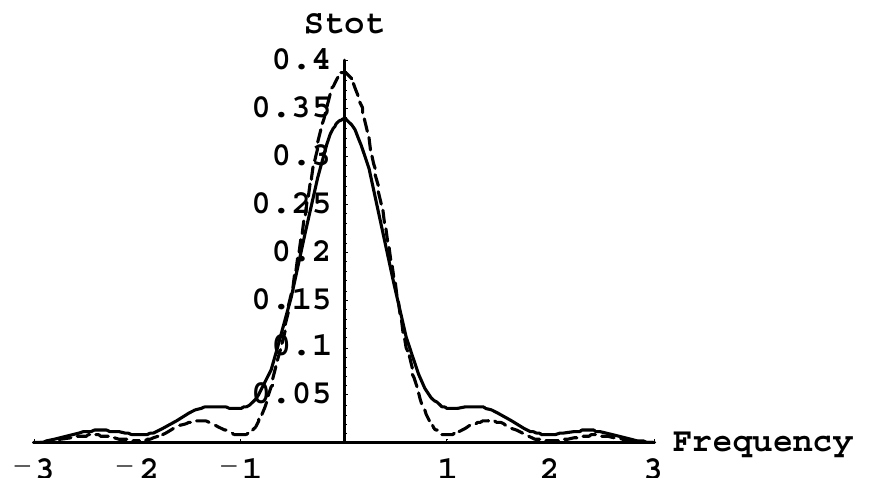
Figure 26. Total profile of all “shifted” components at ε = 0 and two values of q 2 : q 2 = 1/5 (solid line) and q 2 = 1/25 (dashed line). The frequencies are in units of the Kepler frequency Ω of the outer electron (given by Equation (12.3)) [150].